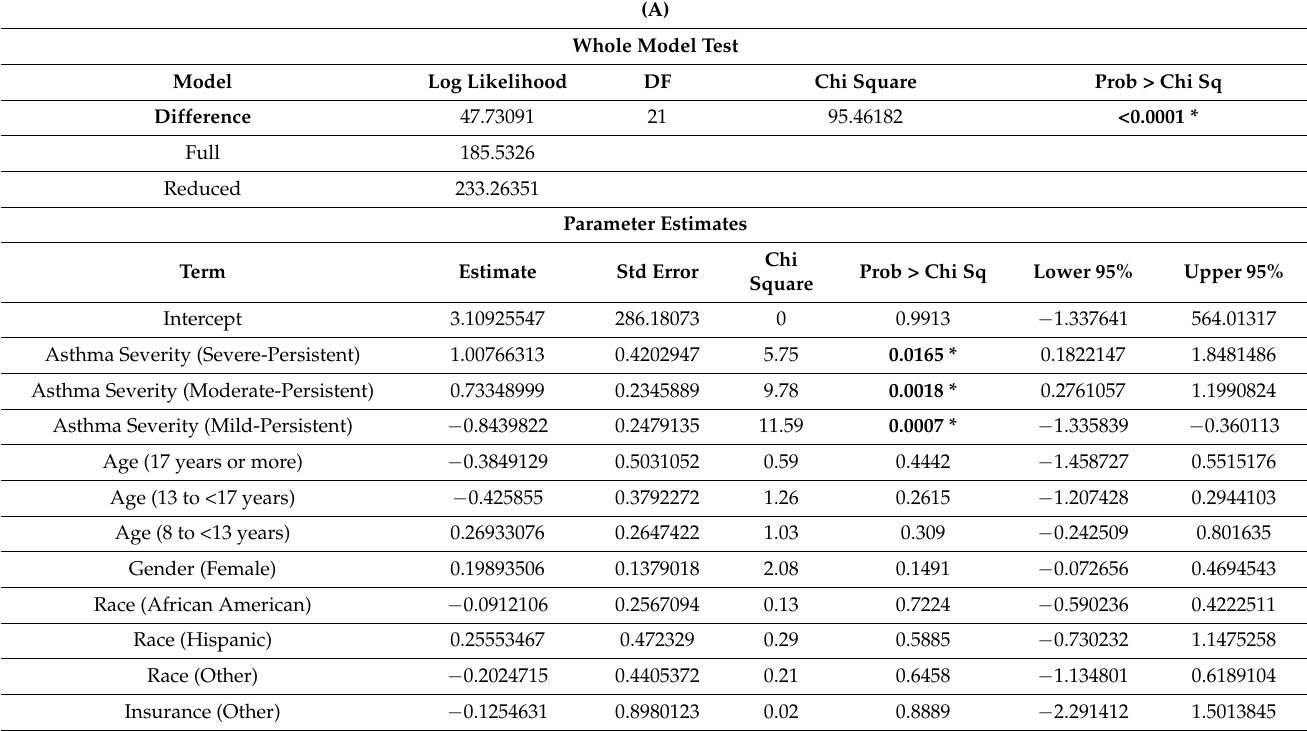
Table 2. ( A ) Logistic Regression Output for DV1 (Part 1). ( B ) Logistic Regression Output for DV1: Odds of User vs. Non-User (Part